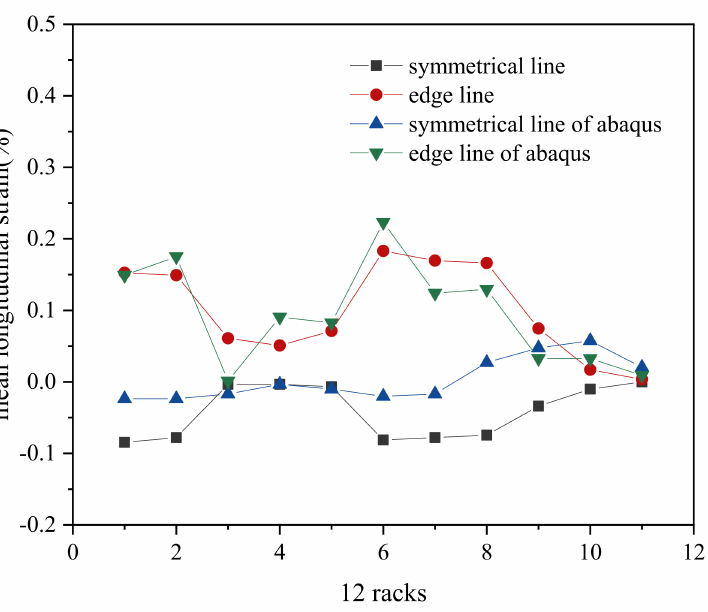
Figure 12. The comparison of the longitudinal strain between the finite element method and analyti- cal